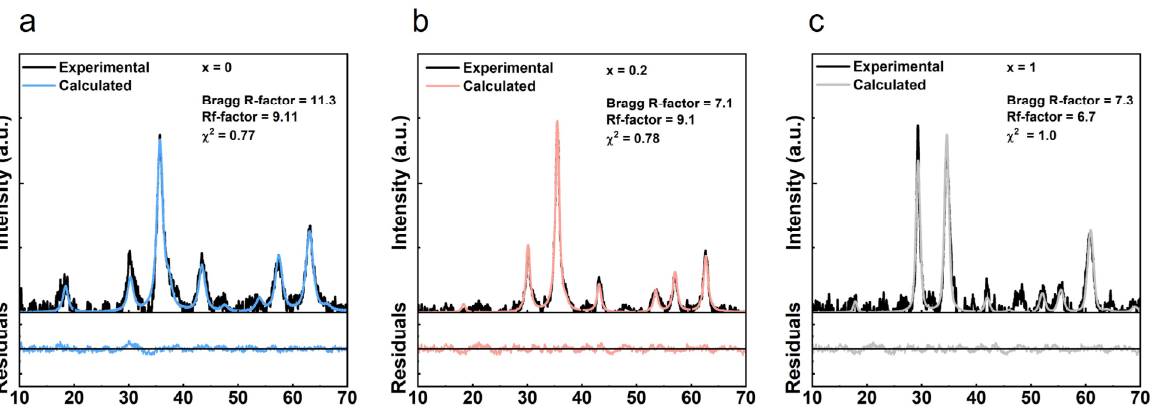
Figure 1. XRD diffraction patterns for Ca x Mn 1- x Fe 2 O 4 ferrites: ( a ) x = 0; ( b ) x = 0.2; ( c ) x = 1, and fitted patterns obtained through Rietveld refinement.